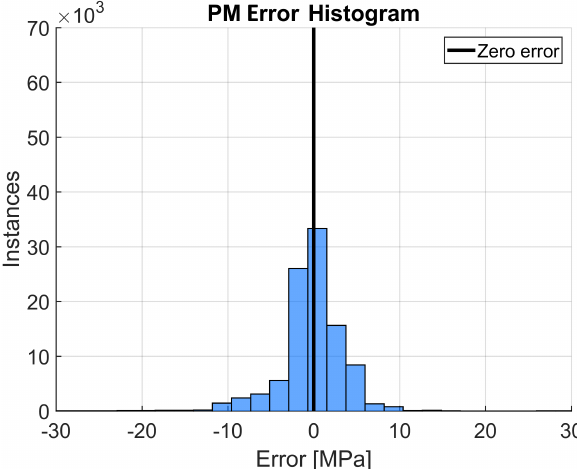
Figure 6. Error histogram for the PM with 30 bins and a bin width of around 2.2 MPa. The results displayed are the difference between the experimental and predicted stress